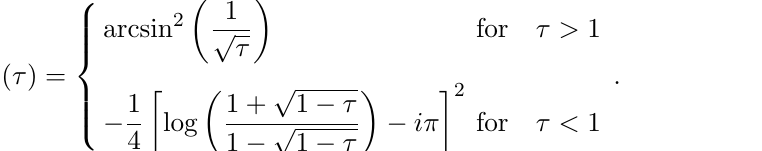
(cid:13)(cid:13) signal !